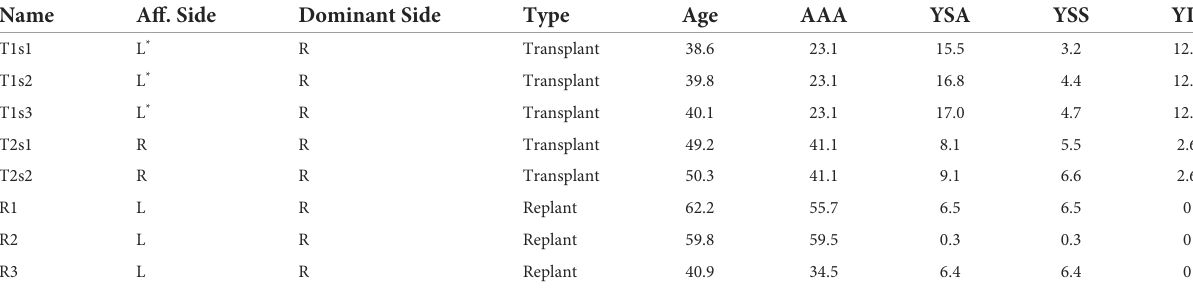
TABLE 1 Demographics of hand restoration